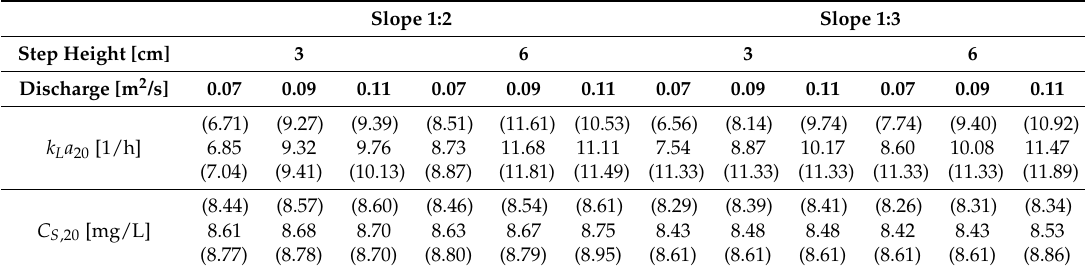
Table 4. Standardized re-aeration performance parameters for all configurations (each averaged from four independent model runs, corresponding minimum and maximum values given in brackets). Slope 1:2 Slope 1:3 3